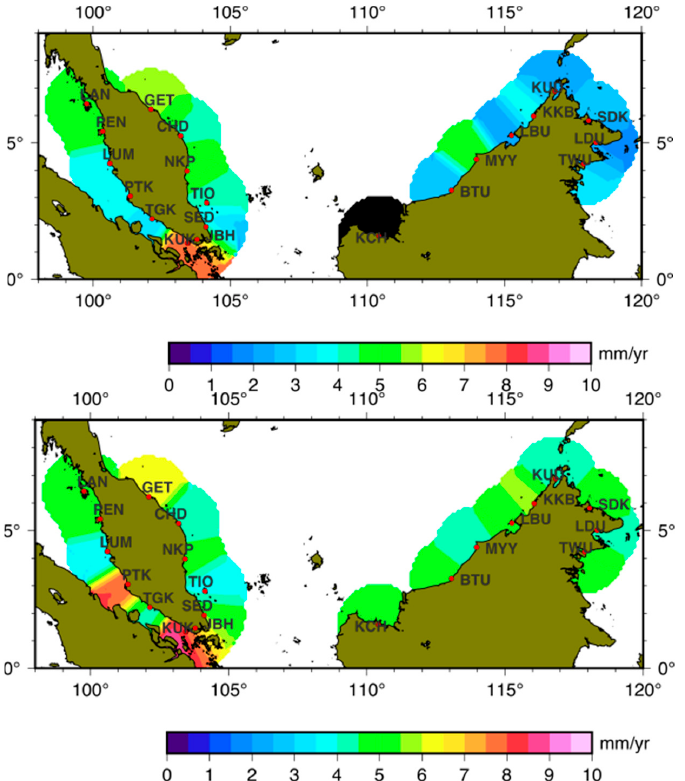
Figure 14. Relative sea-level rise estimates for Peninsular and East Malaysia. The top panel shows the relative sea-level rise from 12 and 9 tide-gauge trend estimates on, respectively, Peninsular (2005–2019) and East Malaysia (1985–2019). The bottom panel shows also the relative sea-level rise, now synthesized from SALT absolute sea-level rise minus GPS vertical land motion, for the same 21 tide-gauge locations in Peninsular (2005–2021) and East Malaysia (1992–2021). The black area in the top panel is due to the erroneous tide-gauge records at station KCH (Kuching), which suggest significant sea-level fall. The 2 red areas in the bottom panel are due to human-induced land subsidence of the GNSS stations in Meru and Kukup. The top panel indicates that this is not registered by the PTK tide gauge near Meru.